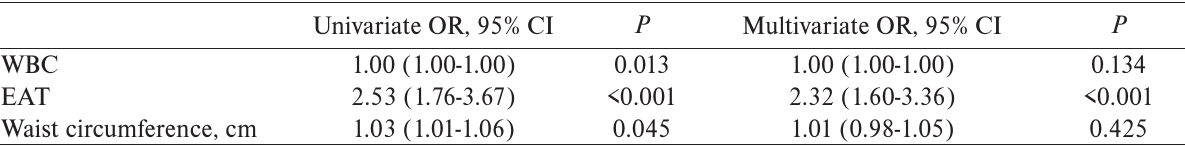
Table 2. Logistic regression analysis in prediction of patients with high thrombus